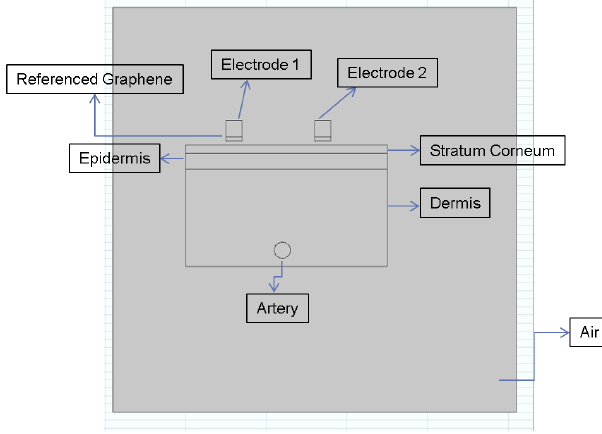
Figure 6. Initial skin model with two electrodes constructed in Comsol. Table 1. Electrical conductivity and relative permittivity values of each layer in Comsol modelling.